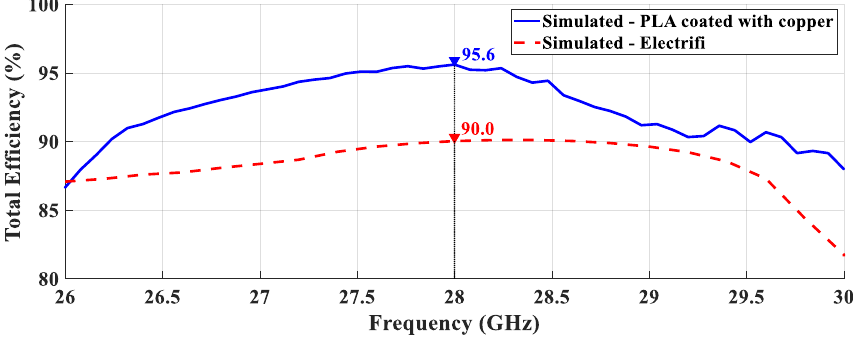
Figure 16. Simulated total efficiency of both antennas.